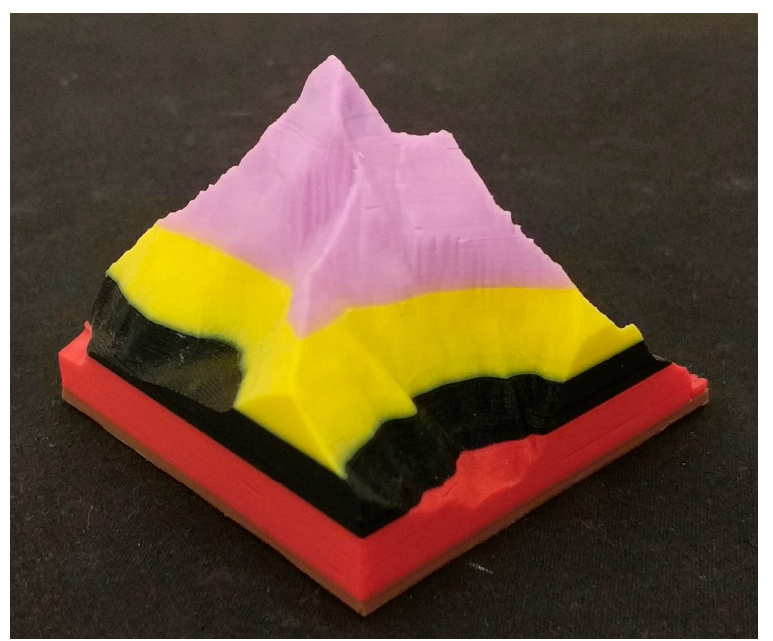
Figure 5. Model produced after five filament advance problems.